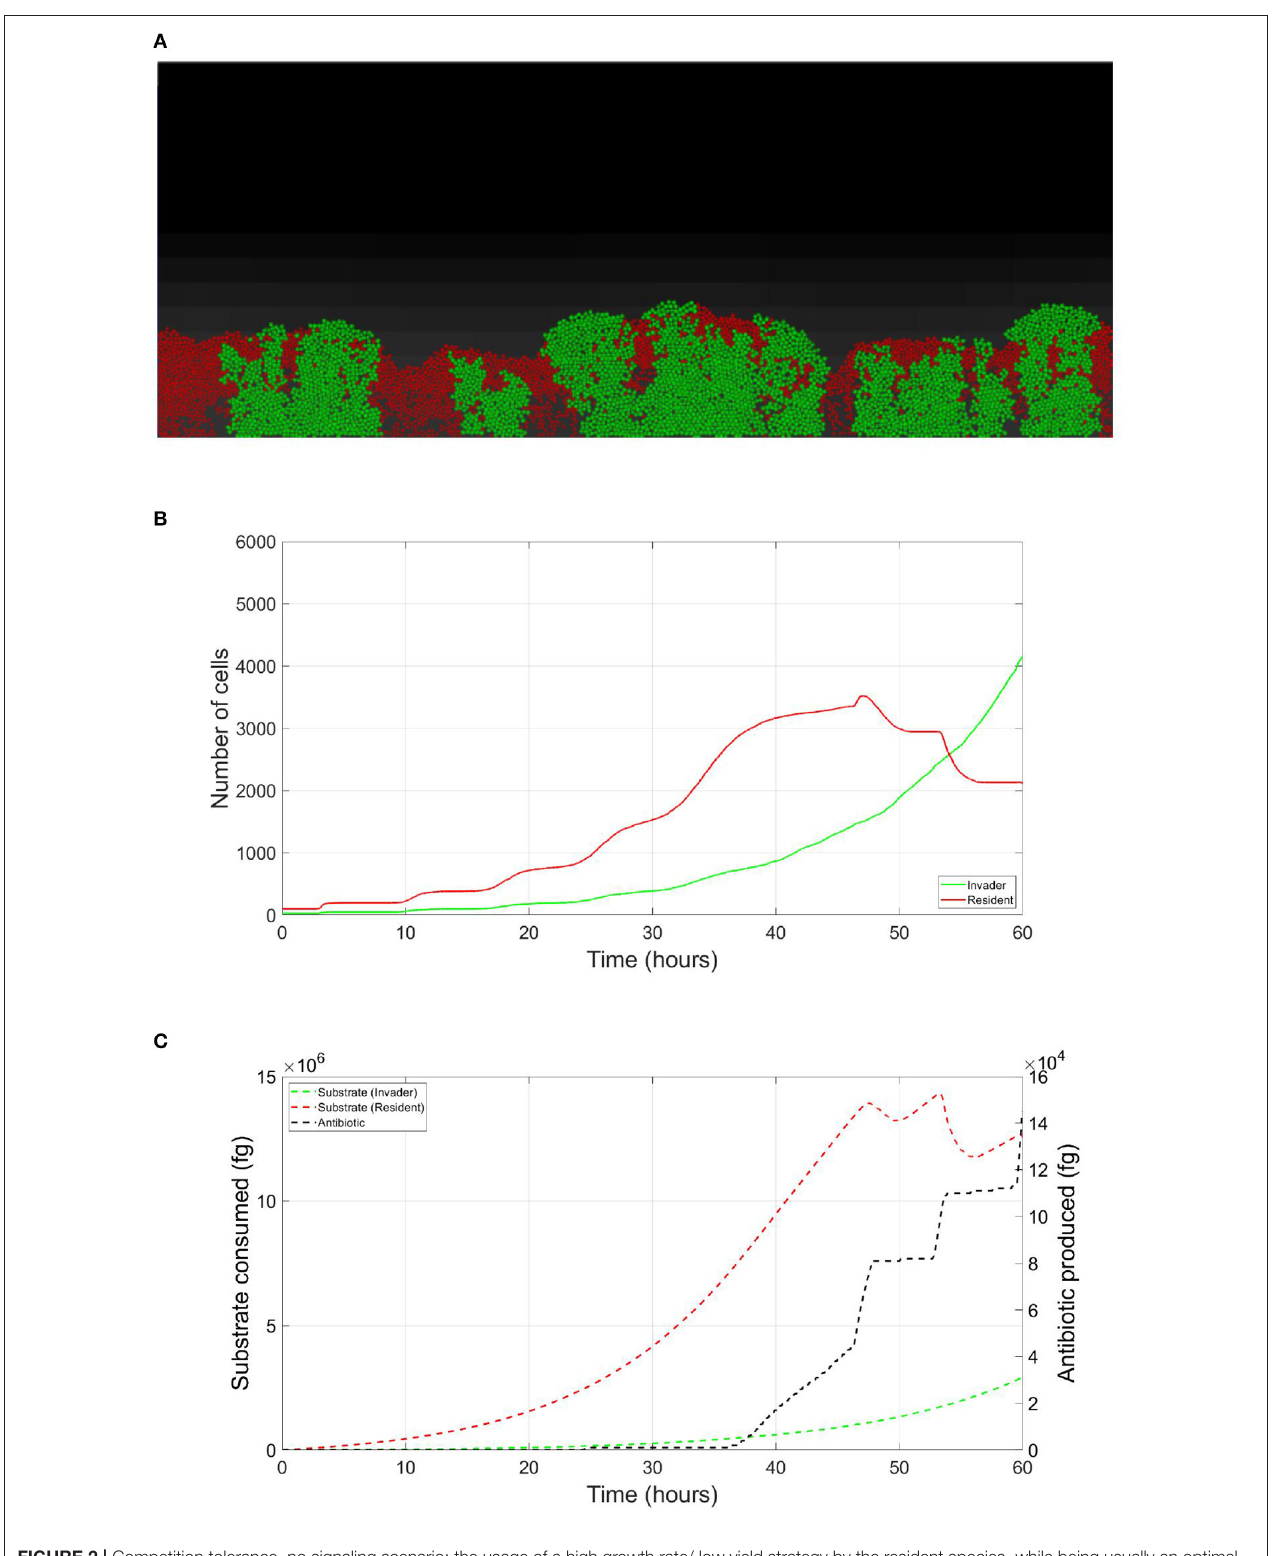
FIGURE 2 | Competition tolerance, no signaling scenario: the usage of a high growth rate/ low yield strategy by the resident species, while being usually an optimal competitive strategy, leads to a quick depletion of nutrients, triggering antibiotic production by the invader species and subsequent decrease in the overall population of both species. (A) A snapshot of the competition between the invader species (green) vs. the resident species (red), by the end of the simulation. (B) The evolution of the population of an antibiotic producing invader and a resident species, growing on the same nutrient. (C) The evolution of the consumption of the nutrient by the invader species (green), and the resident species (red), as well as the production of antibiotic by the invader species (black).